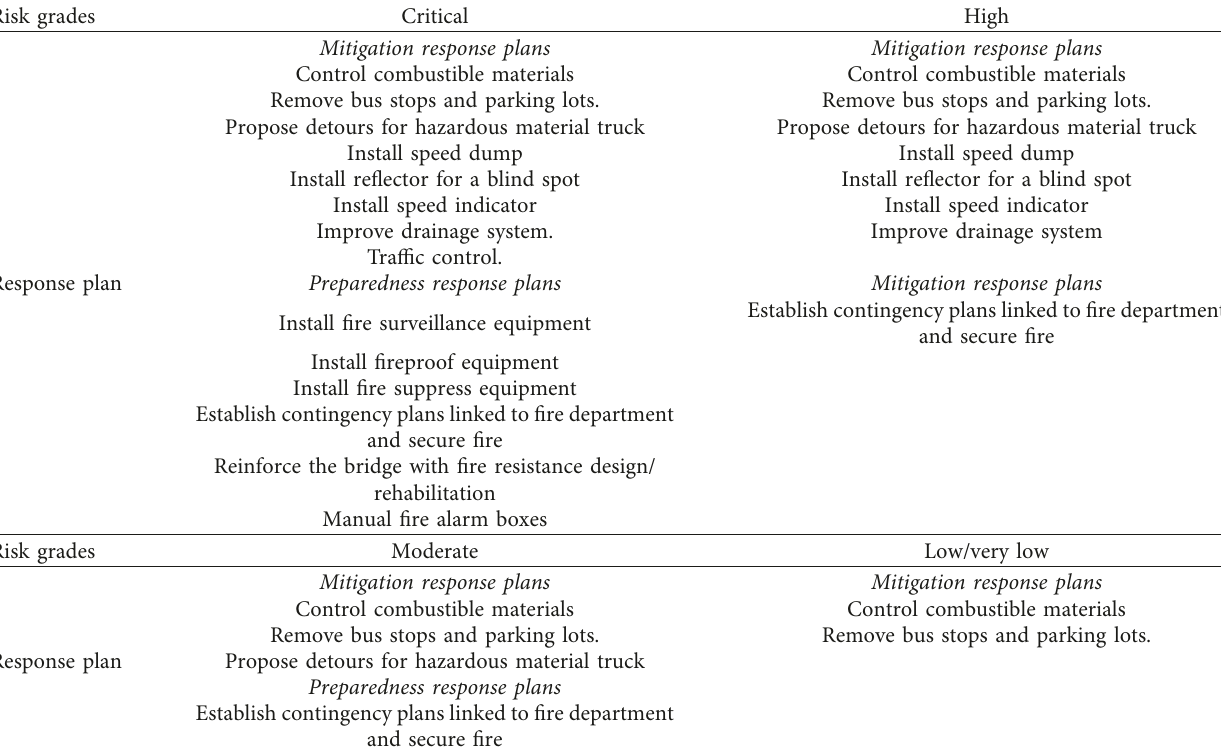
Table 13: Mitigation and preparation response plans depending on risk